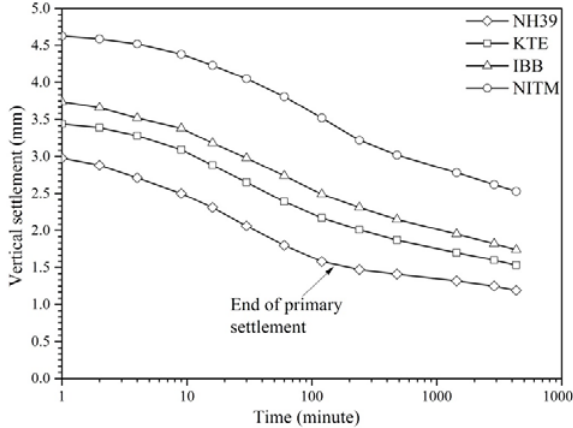
Figure 5. Void ratio - effective stress (e-log 10 σ’ v ) relationship for Northeast Indian peats.